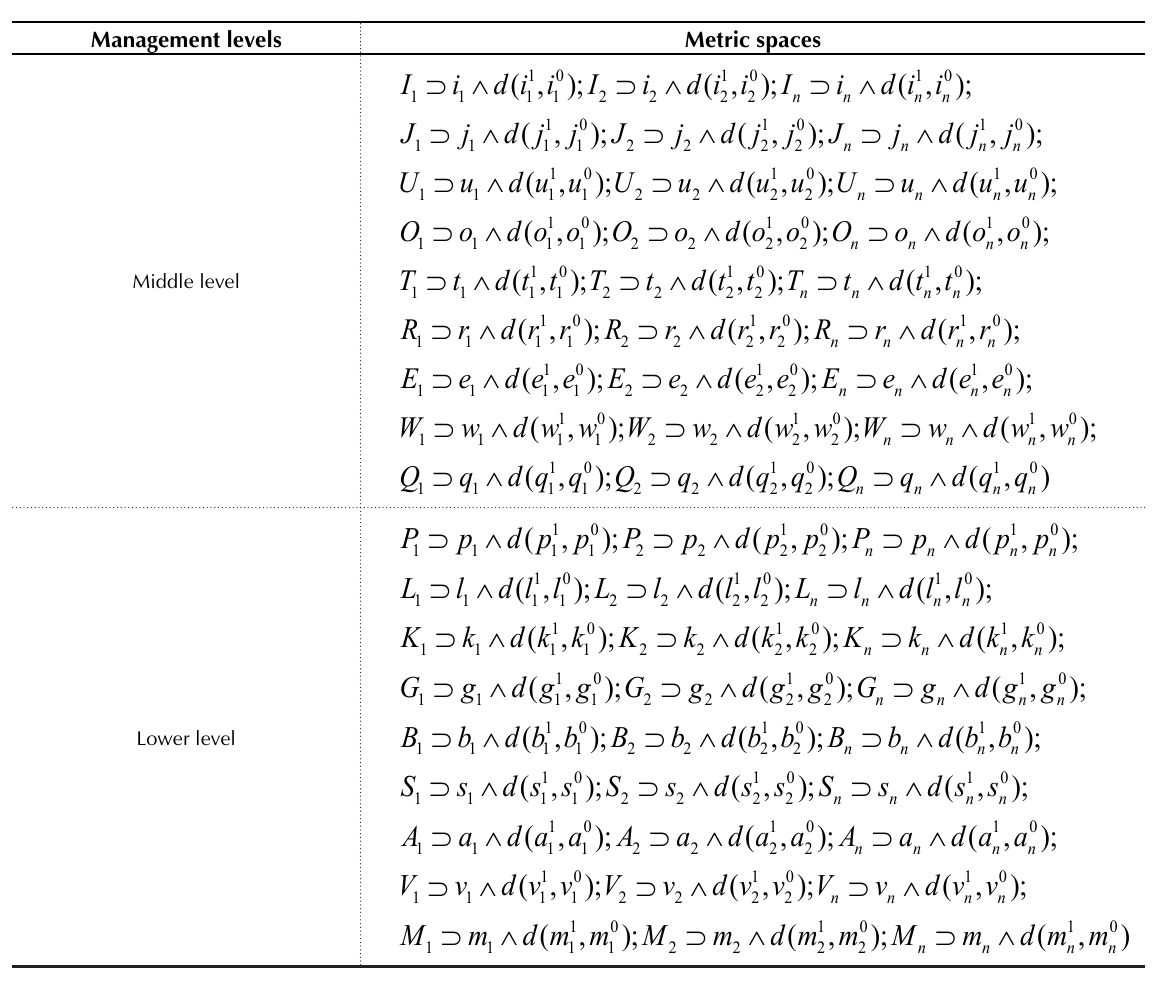
Table 1. Metric spaces of the morphological graphs of ODBMS at the middle and lower management levels Management